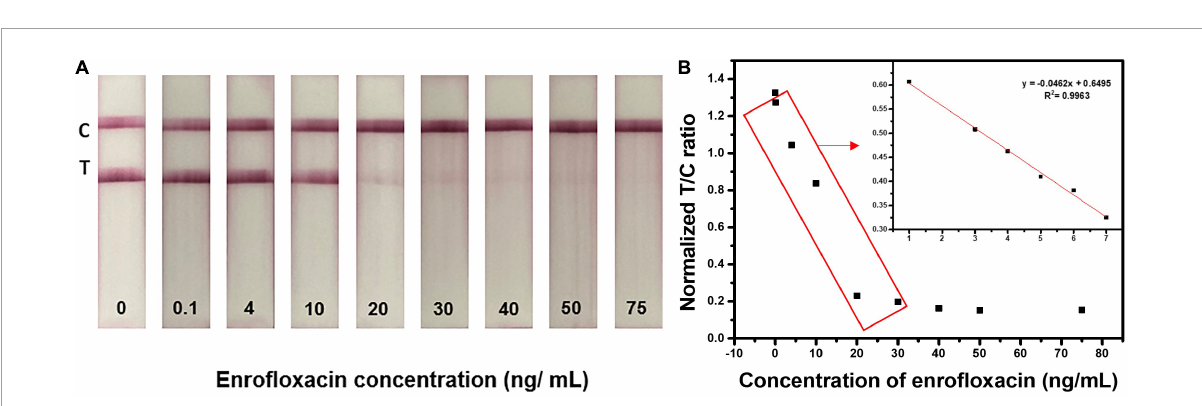
FIGURE6 Detection of ENR in milk samples using optimized LFIA strips. Images of the LFIA test strips for detecting ENR in milk samples with 0, 0.1, 4, 10, 20, 30, 40, 50, and 75 ng/ml concentrations.